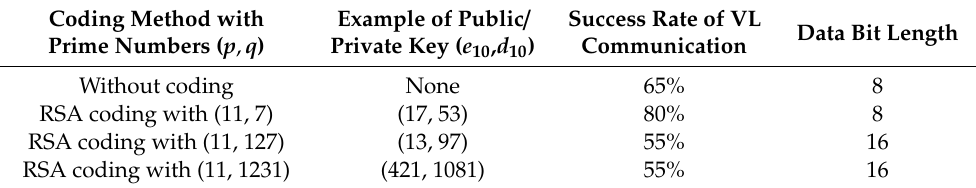
Table 4. Results of real experiment with test